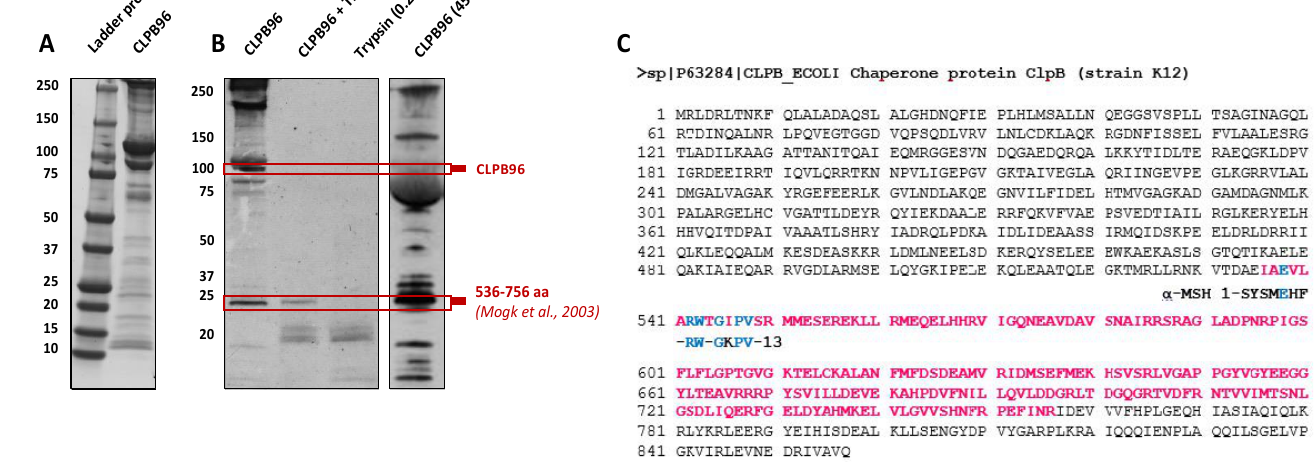
Figure 2. Natural fragmentation of the ClpB protein and identification of CLPB25 in the sequence of CLPB96. Identification by Western Blot of ( A ) natural fragments of CLPB96 stained with Coomassie blue and ( B ) of CLPB25 after enzymatic or thermal fragmentation revealed with polyclonal anti- α -MSH; ( C ) localization of CLPB25 in the sequence of CLPB96 (UniProtKB-P63284 CLPB_ECOLI) according to the previously published sequence [24].